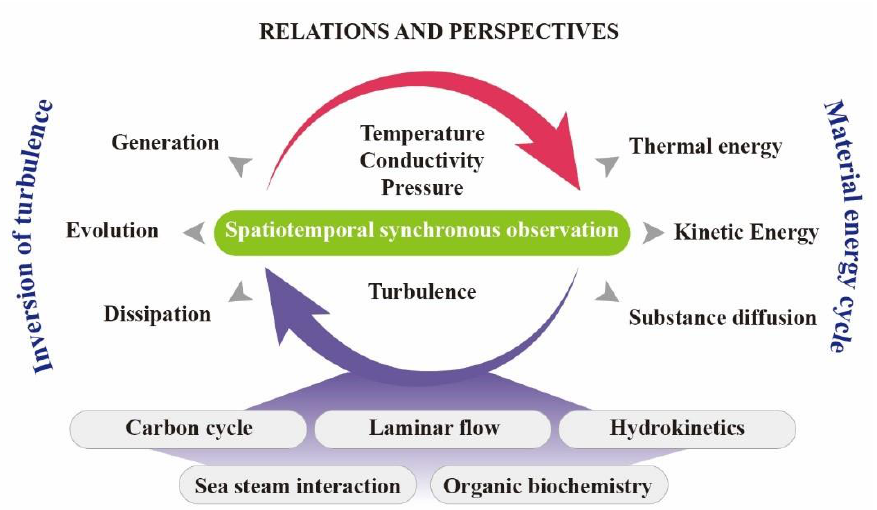
Figure 21. The correlation and perspectives of the spatiotemporal synchronous observation data of temperature, conductivity, pressure and turbulence data.